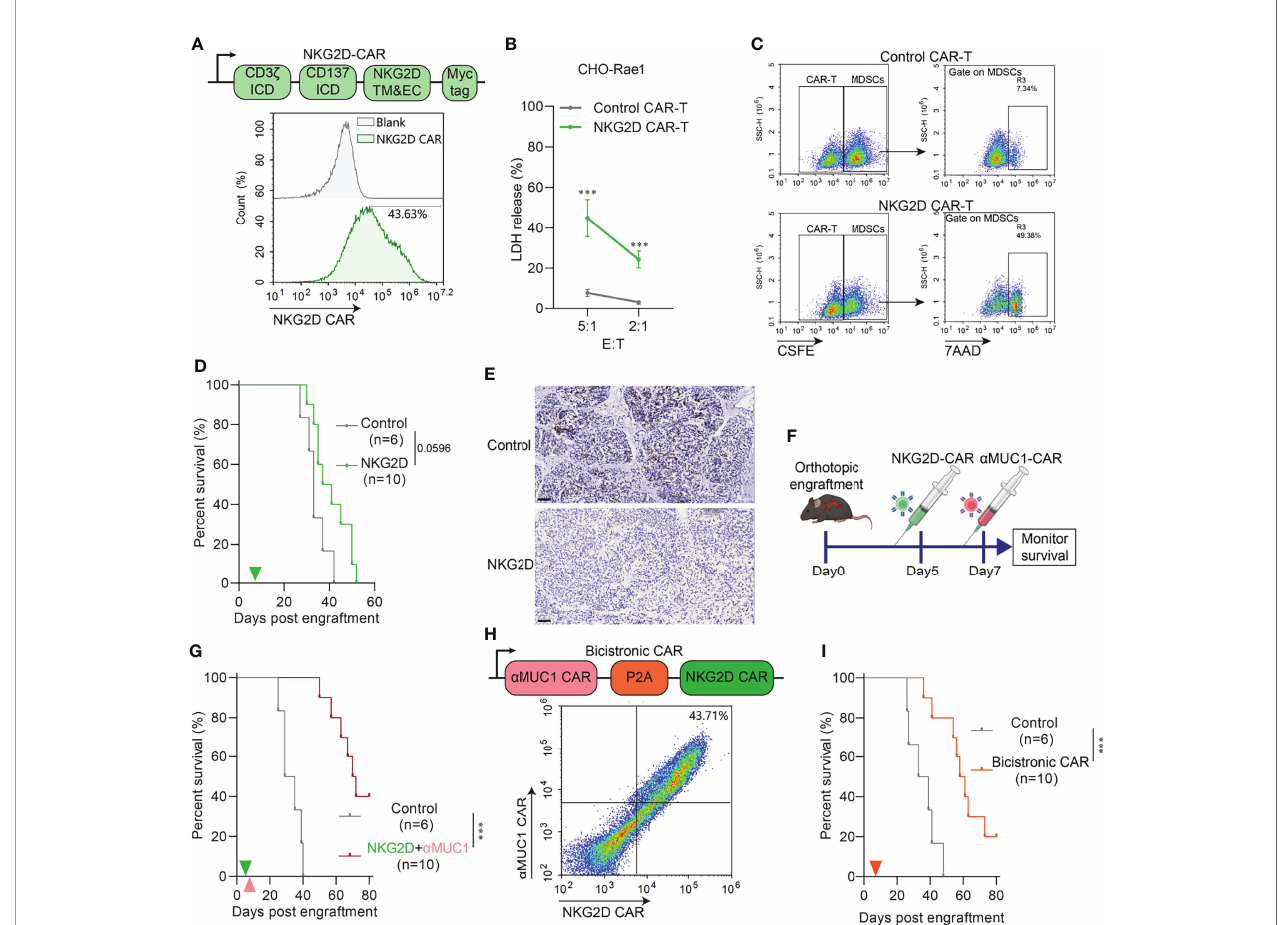
FIGURE 5 | NKG2D CAR-T rescue impaired CAR-T cell activity via eliminating MDSCs. (A) Schematic diagram of NKG2D-CAR (Upper) and fl ow cytometry assay of transfection ef fi ciency (Down). (B) Cytotoxicity assay of NKG2D CAR-T to Rae1 positive CHO cell at indicated E:T ratio. E:T, effector-to-target ratio. (n=6 compared with Control CAR-T group, ***P<0.001). (C) Cytotoxicity assay of NKG2D CAR-T to murine MDSCs at E:T=1:1. MDSCs were pre-labeled by CSFE. CSFE + 7AAD + cells indicate speci fi c killed MDSCs. (D) Survival of orthotopic tumor recipients after NKG2D CAR-T transfer. The green arrows indicate NKG2D CAR-T cells administration. (E) Representative IHC images of Gr1 staining in orthotopic tumor 2 days after NKG2D CAR-T transfer. Scale bar=50 m m. (F) Schematic outline of experimental approaches and analyses. (G) Survival of orthotopic tumor recipients after combination of NKG2D CAR-T and a MUC1 CAR-T. The green arrows indicate NKG2D CAR-T cells administration; the orange arrows indicate a MUC1 CAR-T cells administration. (***P<0.001). (H) Schematic diagram of bicistronic CAR (Upper) and fl ow cytometry assay of transfection ef fi ciency (Down). (I) Survival of orthotopic tumor recipients after bicistronic CAR-T transfer. The orange arrow indicates CAR-T cells administration